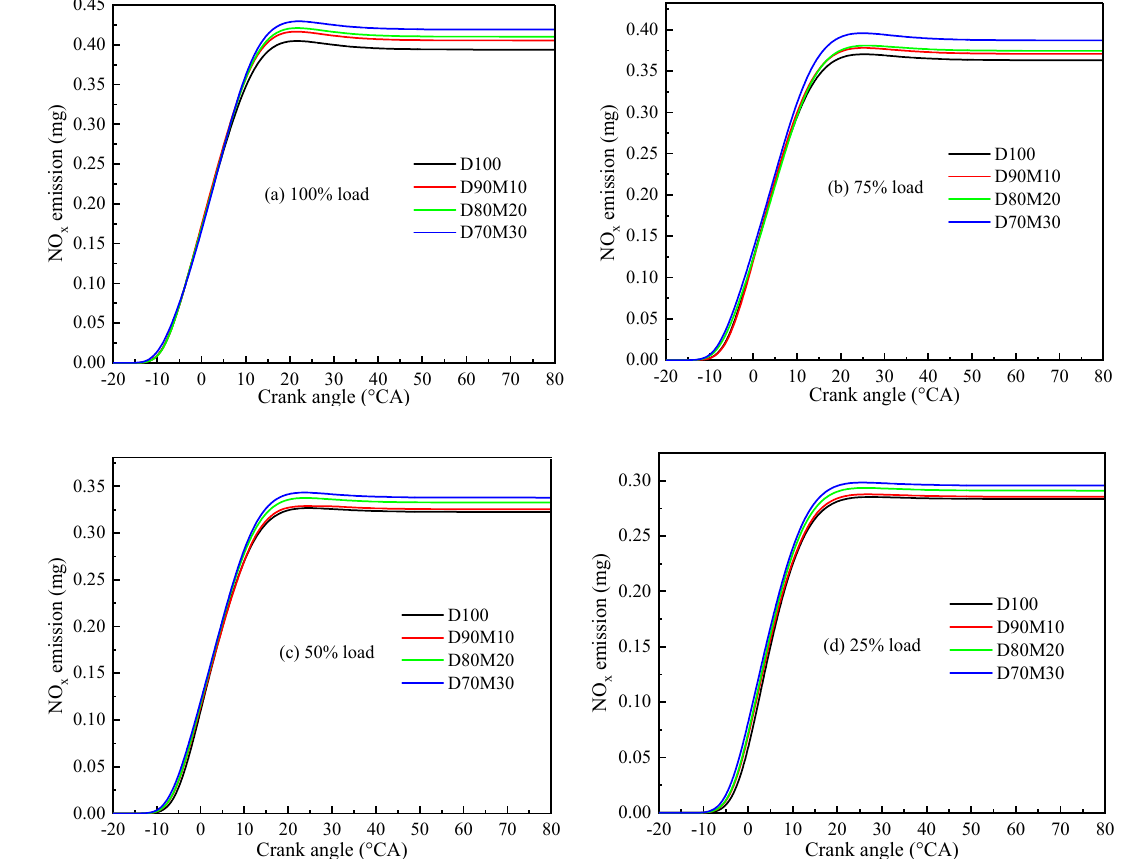
Figure 11. NO x emission curves of different proportions of diesel–methanol blended fuel under different load conditions. ( a ) at 100% load, ( b ) at 75% load, ( c ) at 50% load, ( d ) at 25% load.